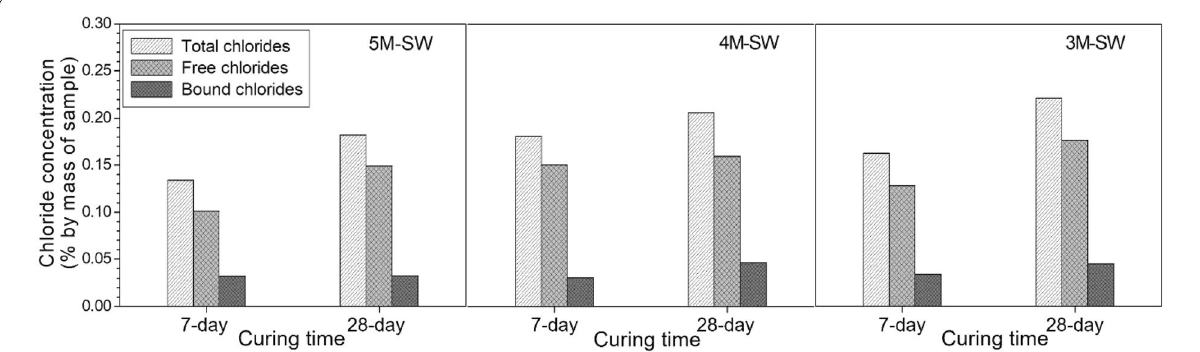
Fig. 5 Chloride content in CO 2 -cured BFS pastes with different activator concentrations during immersion in